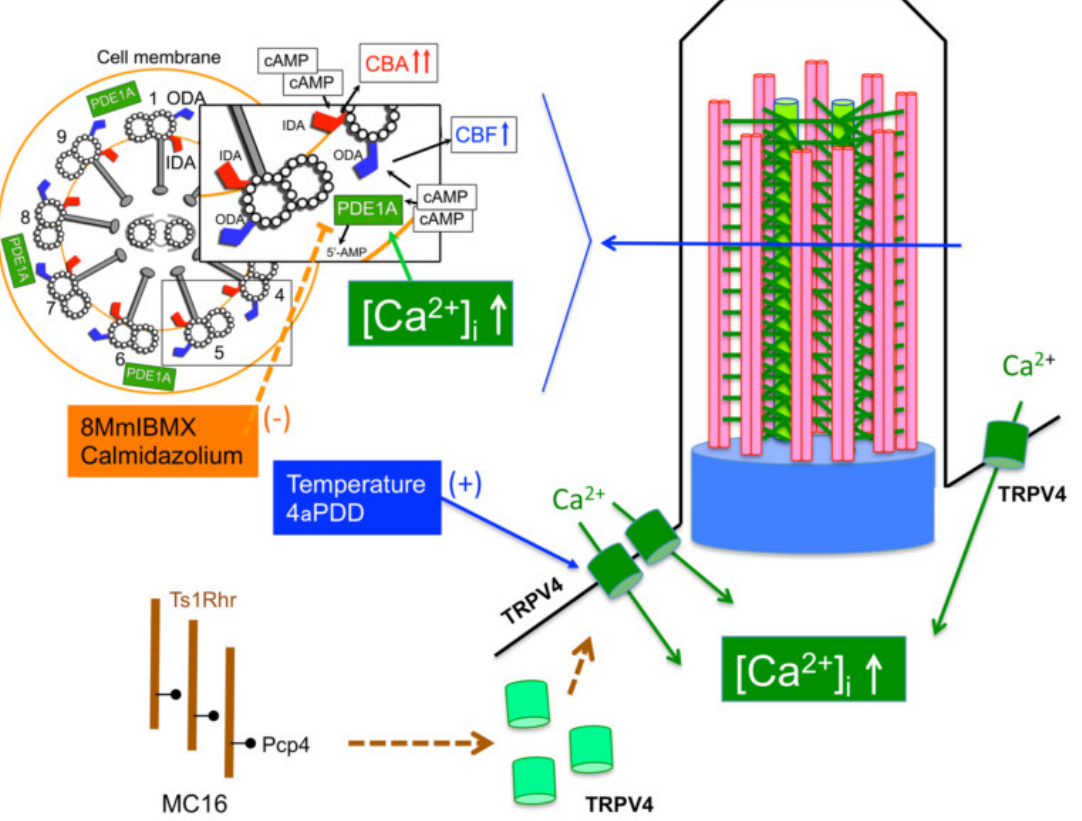
Figure 8. Schematic diagram of airway ciliary cells in DS. Three copies of Pcp4 on Ts1Rhr induce overexpression of PCP4 leading to enhancement of Ca 2+ entry via TRPV4 under the basal condition. A basal [Ca 2+ ] i increase on early embryonic day may affect axonemal regulatory complexes regulated by Ca 2+ . A basal [Ca 2+ ] i increase activates PDE1A existing in the metabolon regulating ODAs, leading to suppression of cAMP accumulation.